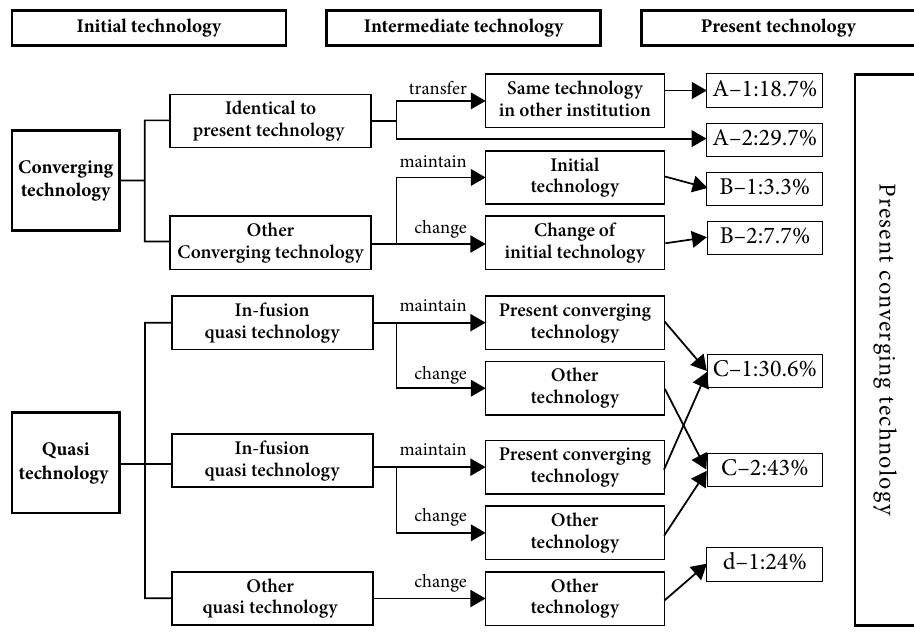
Fig. 3. Career path classification for convergence technology researchers